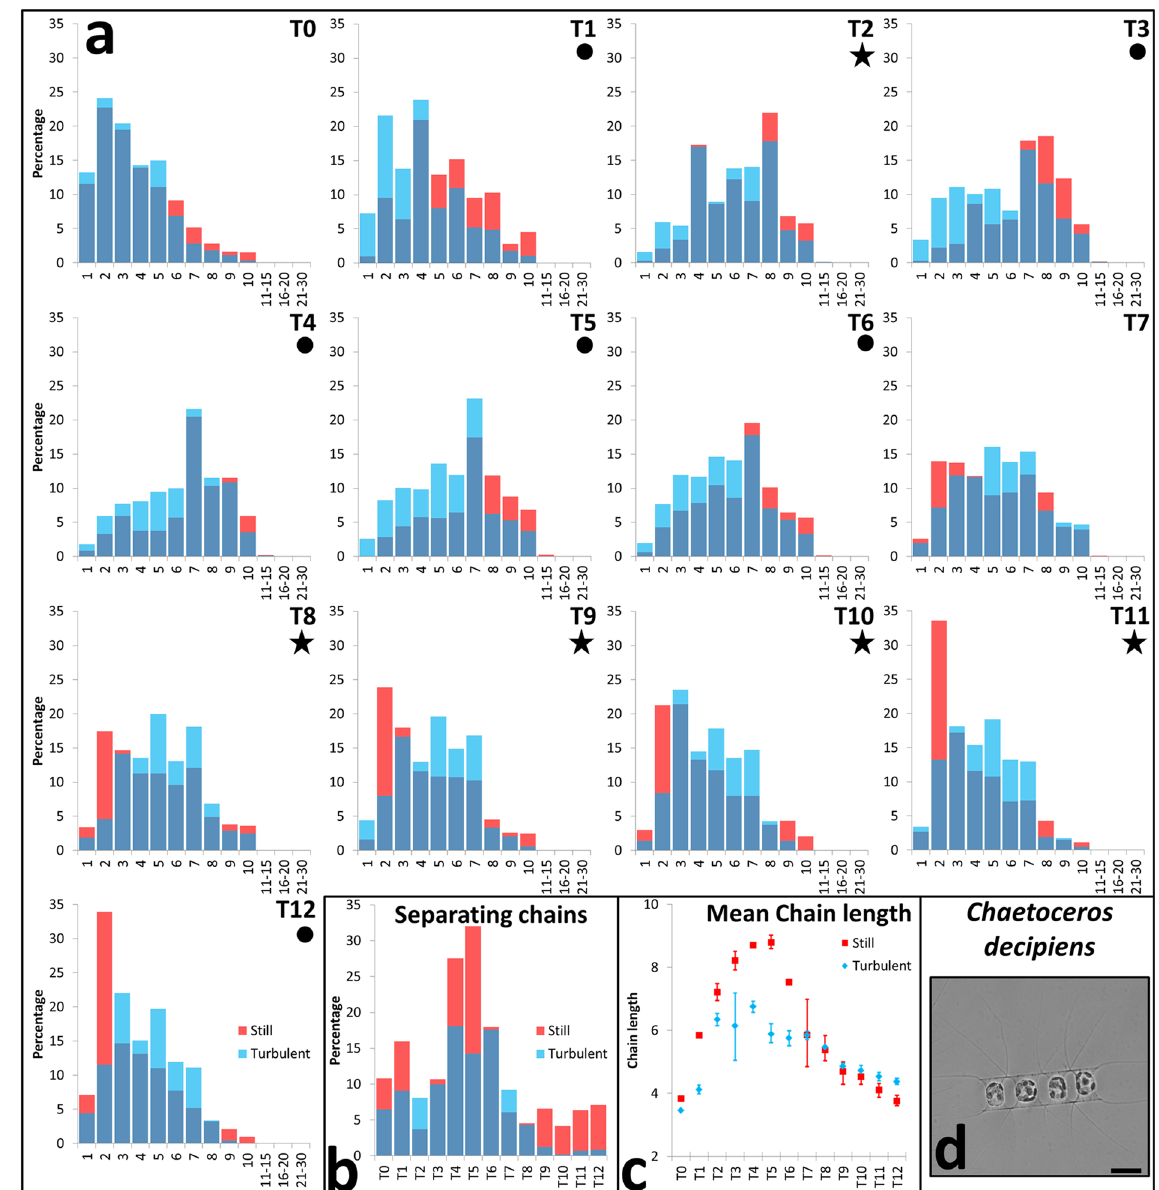
Figure 3. Chain spectra over experimental days (T0–T12) ( a ), separating chain frequency ( b ), mean chain length ( c ), in the centric diatom C. decipiens ( d ). ( a ) Abscissa represents the chain length expressed as number of cells per chain, ordinate the frequency of each chain class expressed in percentage. All results were statistically validated by Kolmogorov-Smirnov two-sample (KS2) and Wilcoxon non parametric tests (Supplementary Table 5). A full circle indicate that both test responses equal 1 with a p -value < 10 − 10 , a black star indicate p - value between 10 − 4 and 10 − 10 , no symbols below the time point indicate that both test responses equal 0 with a p -value above 10 − 3 . KS2 and Wilcoxon tests were also run in order to test statistical robustness of biological replicates. Tests were run in pairwise combinations between replicates (Supplementary Table 5). Dark blue portions of the histograms indicate overlap, red histograms indicate enrichment of a given chain class in the still condition, blue histograms indicate enrichment in the turbulent condition. ( b ) Abscissa represents the time points expressed in days (T0–T12). ( c ) Mean chain length over time (Abscissa represents time points). Vertical bars indicate maximum and minimum values (n = 2). ( d ) a Chaetoceros decipiens 4-celled chain. Scale bar indicate 20 µ